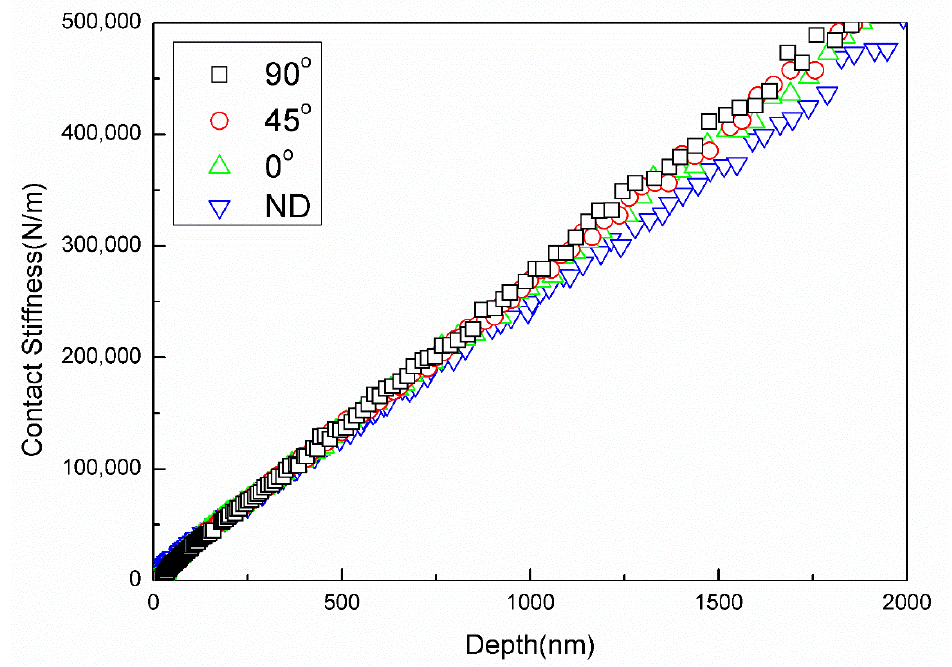
Figure 3. Nanoindentation contact stiffness - depth curves obtained during the loading of rolled AZ31 alloys in four directions.